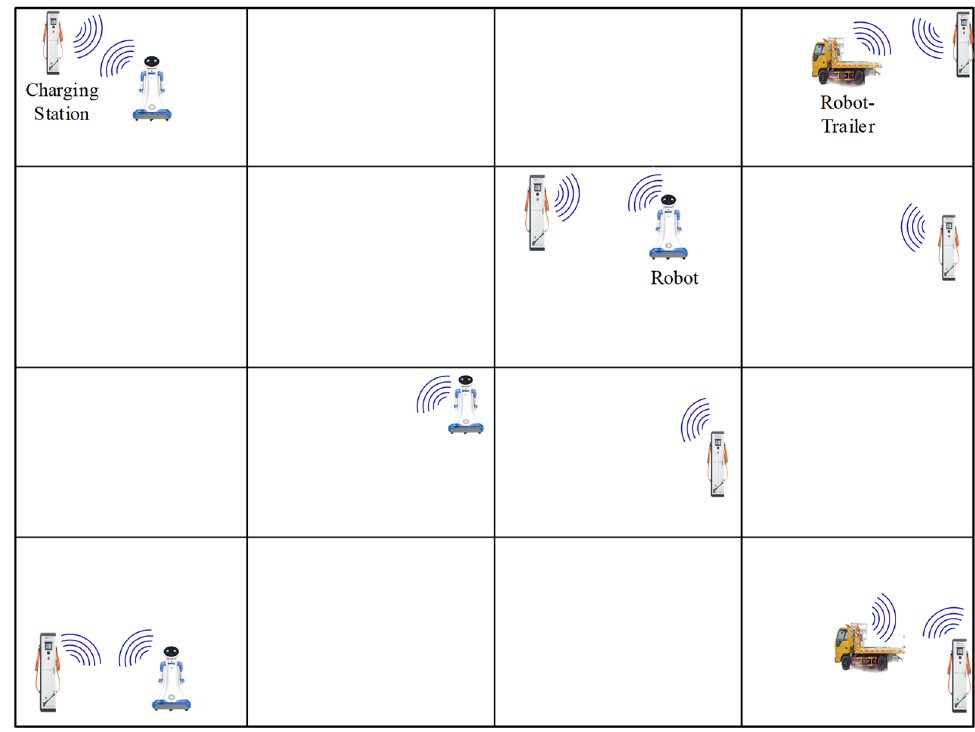
Figure 1. Working diagram of indoor robot-trailer.